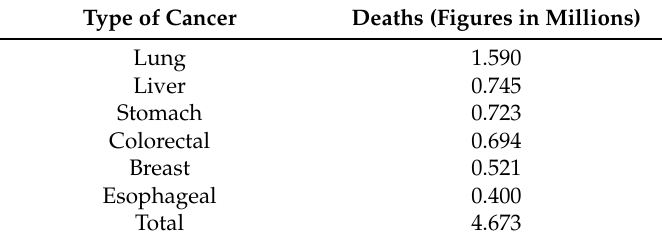
Table 1. Deaths by major types of cancer in 2012